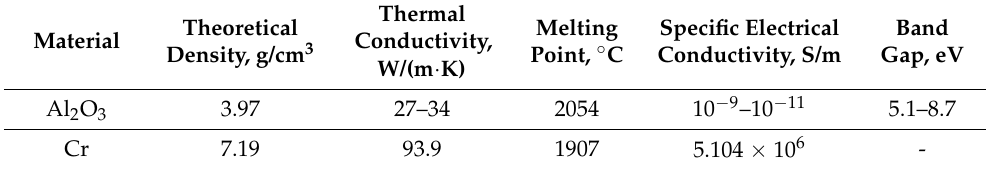
Table 1. Material parameters at 20 ◦ C.